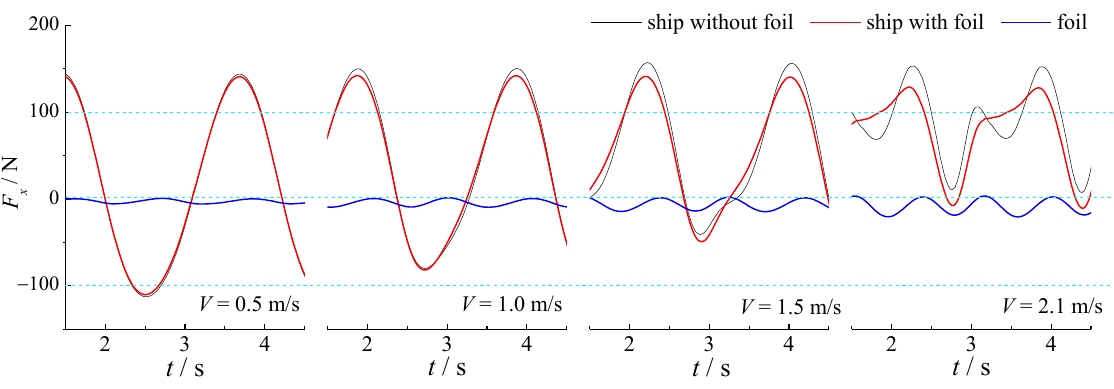
Figure 13. Time traces of the axial force F x acting on the hull and flapping foil (black line: normal hull without bow foil; red line: hull with bow foil; blue line:rotation axis of bow foil).